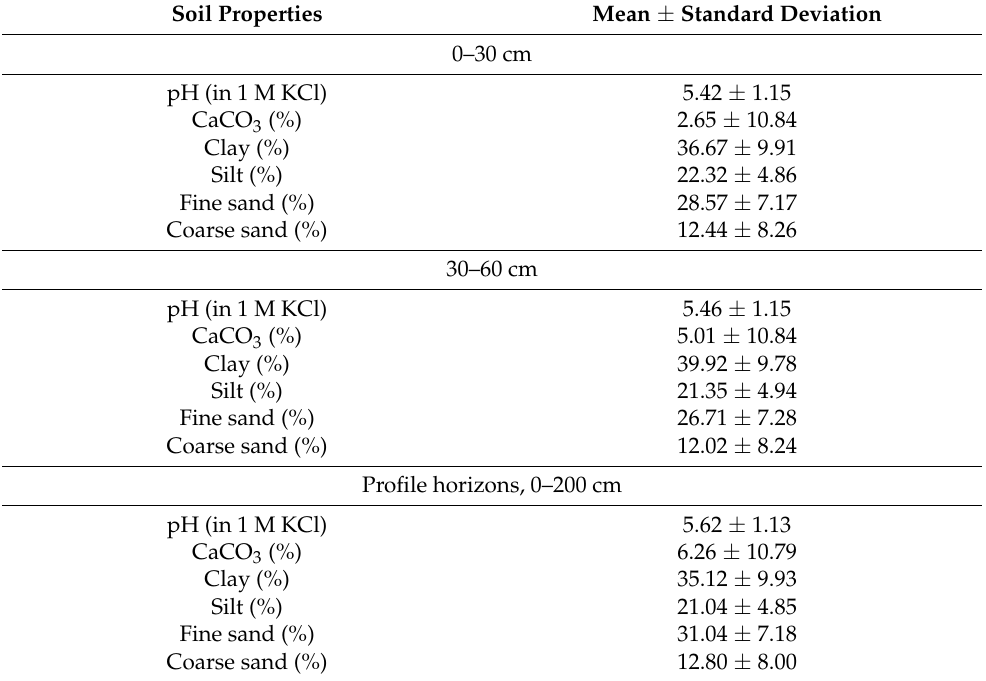
Table 3. Descriptive statistics of soil properties in layers: 0–30 cm, 30–60 cm and profile horizons (<200